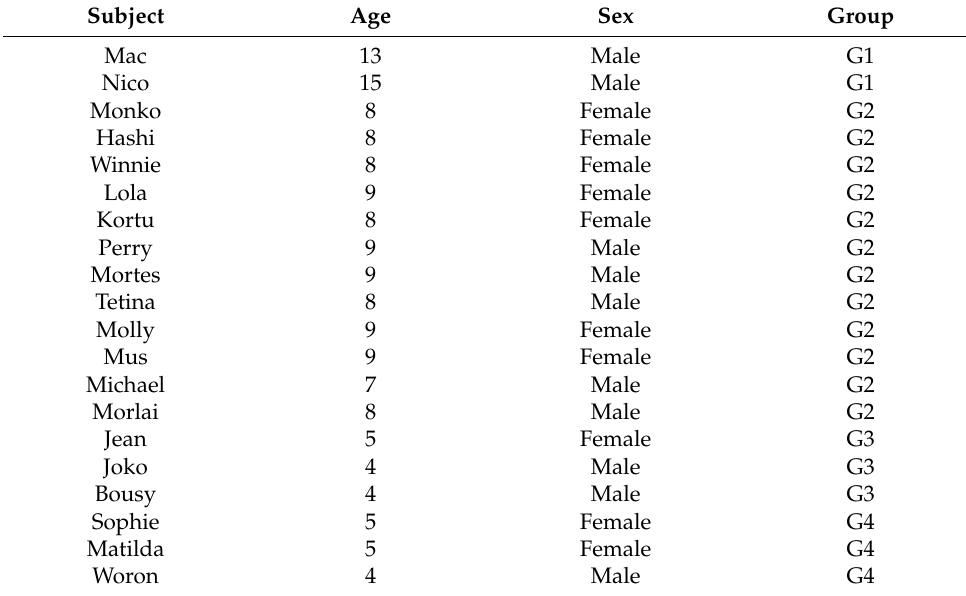
Table 1. Summary of all study subjects and relevant characteristics.